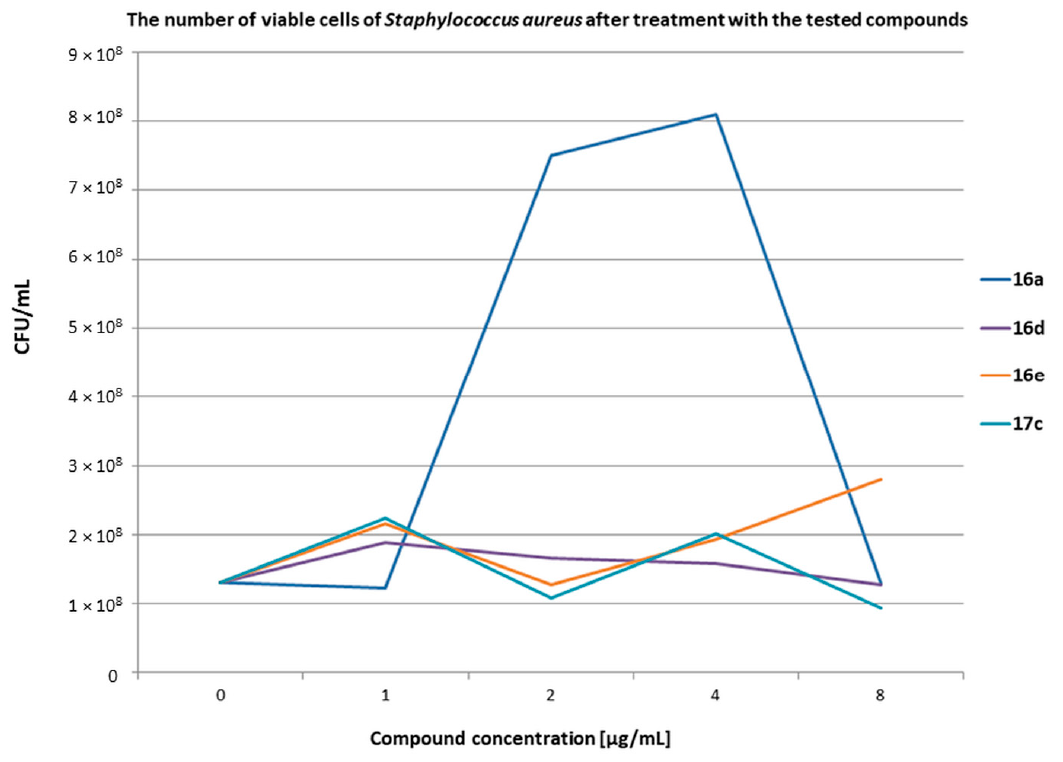
Table 2. The results of the measurement of the number of viable cells of Staphylococcus aureus after the action of the tested compounds at various concentrations.